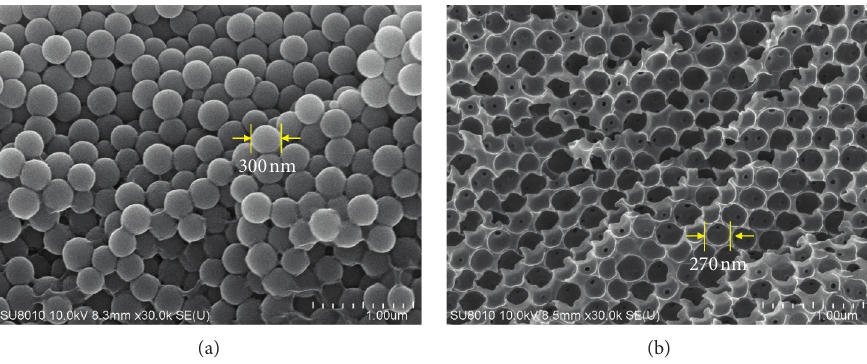
Figure 2: SEM images of PEGDA/SiO 2 before (a) and after etching with BOE